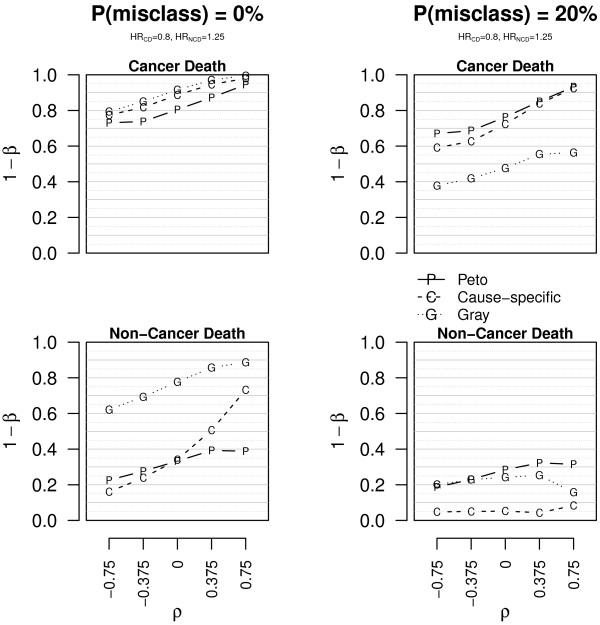
Empirical power of the tests in scenario 4. Empirical power (1 - β) of the tests for CD and NCD in scenario 4 (HRCD = 0.8, HRNCD = 1.25). The data are simulated without censored observations. The plots on the first line concern CD, those on the second line NCD. The plots on the left are for data with correct causes of death (P(misclass) = 0%), those on the right for data with 20% of misclassified causes of death (P(misclass) = 20%).